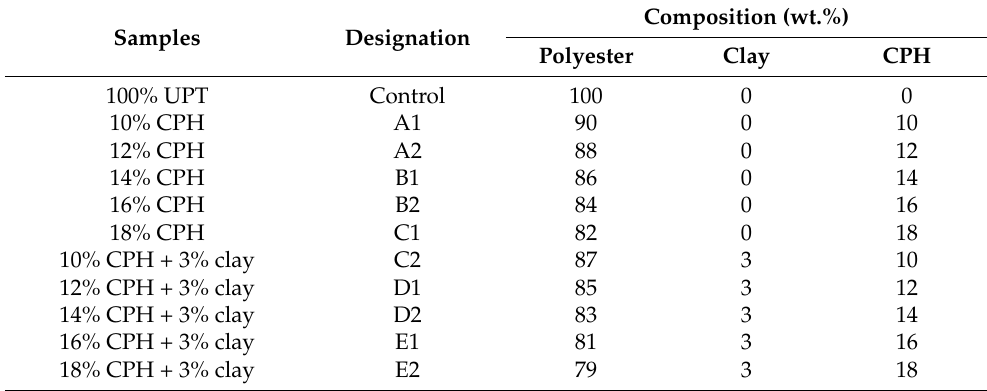
Table 1. Experimental design of composite.